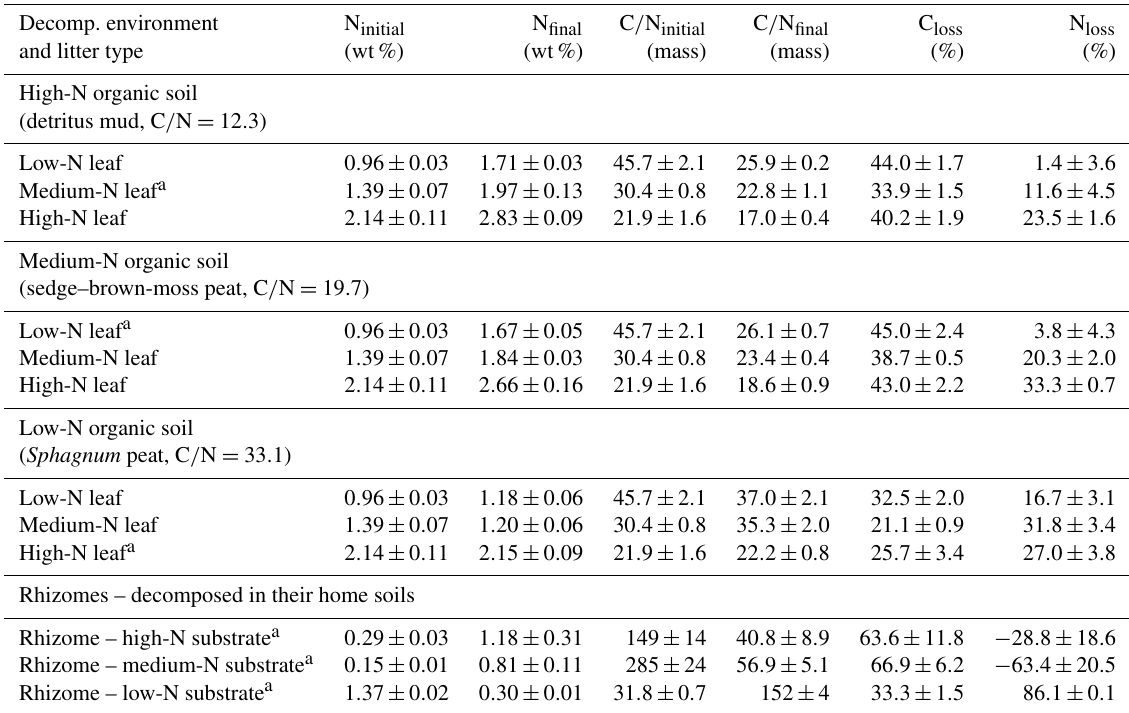
Table 1. Bulk nitrogen (N) contents and carbon : nitrogen ratios (C / N) of initial and anaerobically decomposed Phragmites australis leaves and rhizomes. Decomp.